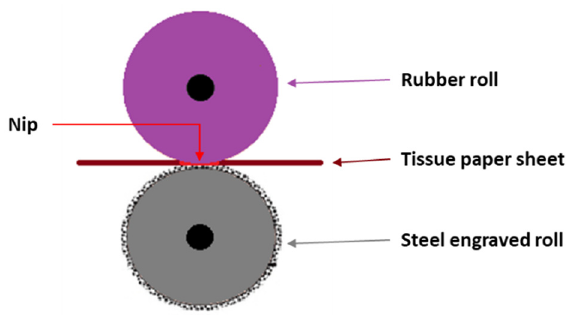
Figure 1. Schematic of the main performers in the tissue-paper-embossing process.